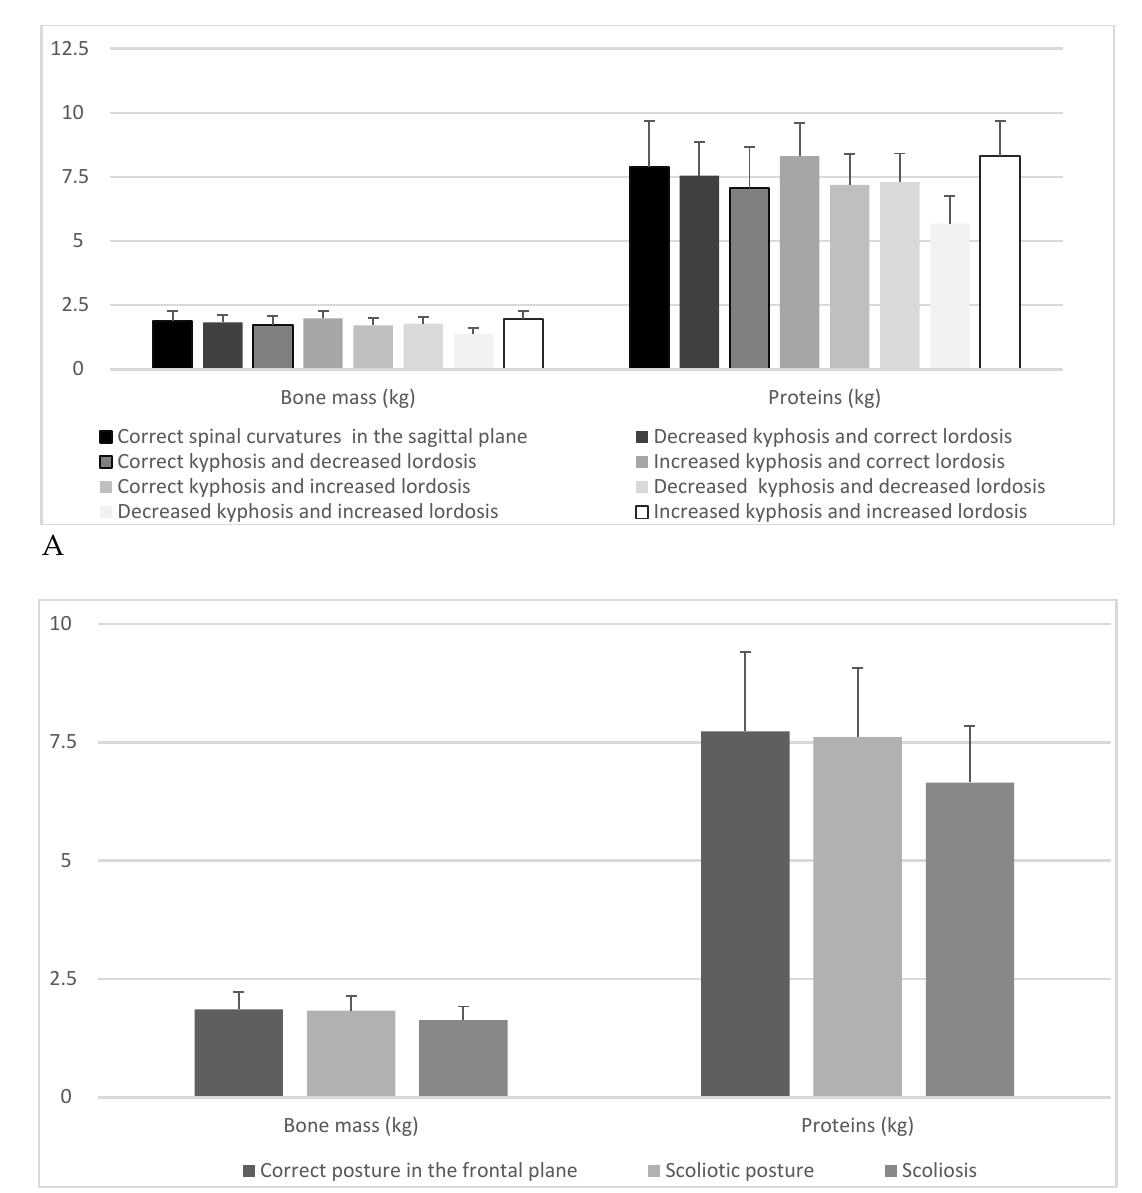
Figure 4. Basal metabolic rate and: sagittal spine types ( A ) and correct posture in the frontal plane, scoliotic posture and scoliosis ( B ).